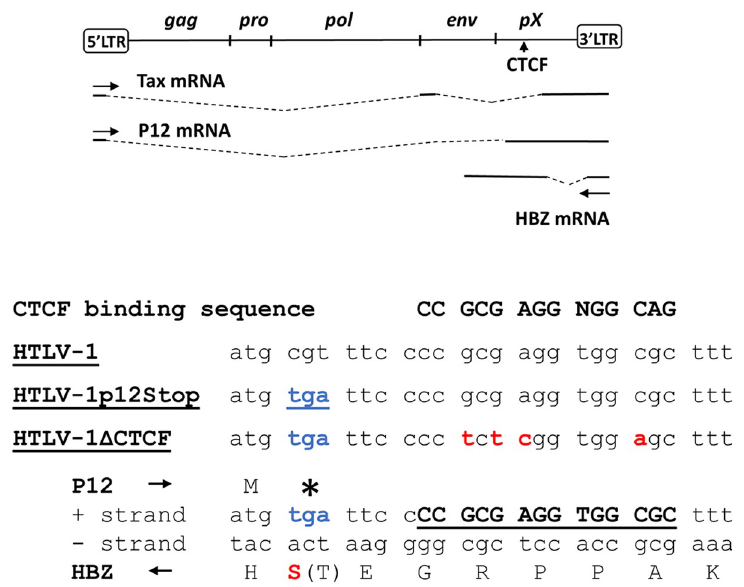
Fig 1. HTLV-1 molecular clone with mutations in CTCF binding site (vCTCF-BS). The top panel shows a schematic of the HTLV-1 proviral genome, and the positions of the pX domain (nucleotides 6619-8281), and the vCTCF-BS. Positions of sense-strand spliced tax and p12 transcripts and the predominant antisense hbz transcript are depicted. The bottom panel shows the consensus CTCF binding sequence, and the adjacent nucleotide sequence in wild type HTLV-1. A control virus was constructed with a termination codon in p12 (blue) in place of alanine residue 77, designated HTLV-1p12Stop. A mutant virus was constructed with mutations (red) in the vCTCF-BS, as well as